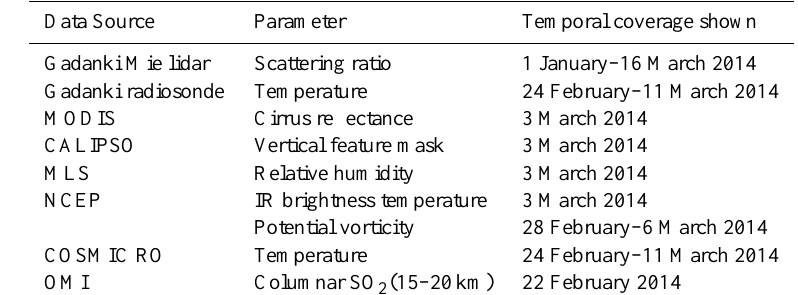
Table 1. Data sets used, parameters and their temporal coverage shown.